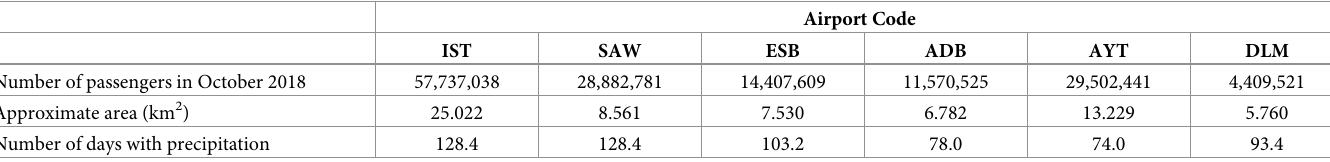
Table 4. Data sample for the total number of airline passengers at six airports (general directorate of state airports authority, 2019), approximate-area measure- ments, and average number of precipitation days of six airports (Turkish State meteorological service,